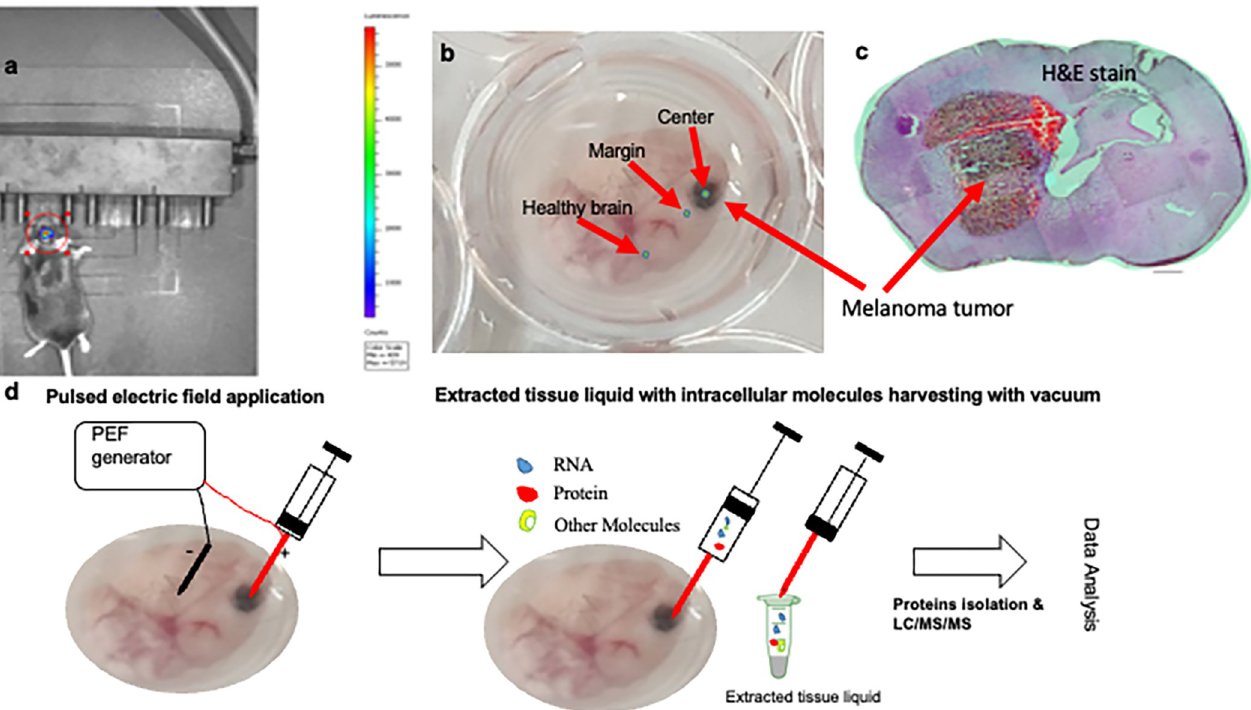
Fig 1. a. In vivo bioluminescent imaging of mice 14-days following RET-mCherry-Luc2 cells implantation. b. Excised mice brain with melanoma metastasis with labeled positions for e-biopsy c. hematoxylin and eosin (H&E) stain of the brain with melanoma metastasis. d. Schematic depiction of molecular harvesting with e-biopsy ex vivo